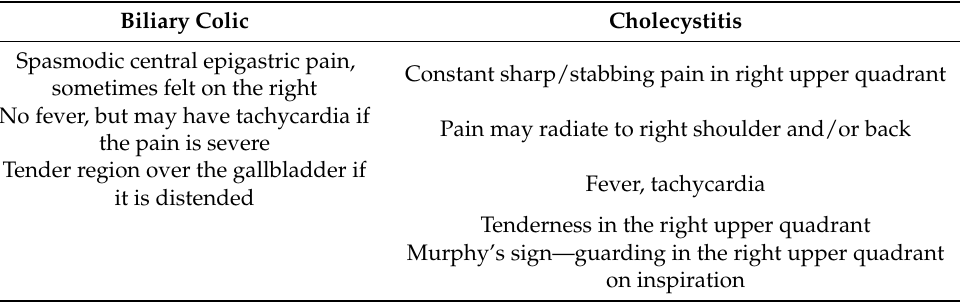
Table 4. Distinguishing features between biliary colic and cholecystitis. Biliary Colic Cholecystitis Spasmodic central epigastric pain, Constant sharp/stabbing pain in right upper quadrant sometimes felt on the right No fever, but may have tachycardia if Pain may radiate to right shoulder and/or back the pain is severe Tender region over the gallbladder if Fever, tachycardia it is distended Tenderness in the right upper quadrant Murphy’s sign—guarding in the right upper quadrant on